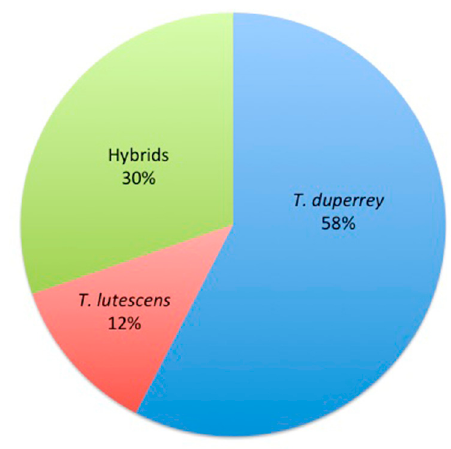
Figure 6. The proportion of individual fish identified as Thalassoma duperrey X lutescens hybrid, as Thalassoma duperrey or as Thalassoma lutescens . Data shown in Table 1. Table 1. Surveys of Thalasssoma species.